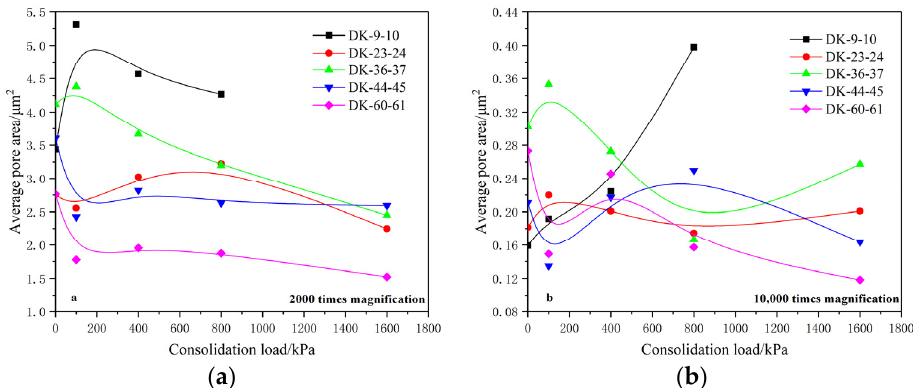
Figure 9. Relationship between the average pore area and consolidation load. (a) 2000 times magnification; (b) 10,000 times magnification.